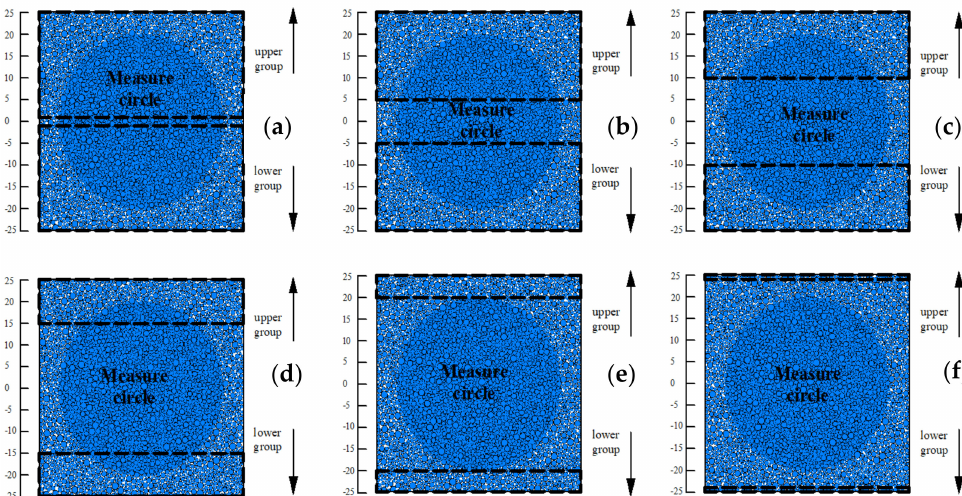
Figure 5. Schematic diagram of specimen tensile movement position (( a ): tensile position 1~25 mm and − 1~ − 25 mm; ( b ): tensile position 5~25 mm and − 5~ − 25 mm; ( c ): tensile position 10~25 mm and − 10~ − 25 mm; ( d ): tensile position 15~25 mm and − 15~ − 25 mm; ( e ): tensile position 20~25 mm and − 20~ − 25 mm; ( f ): tensile position 24~25 mm and − 24~ − 25